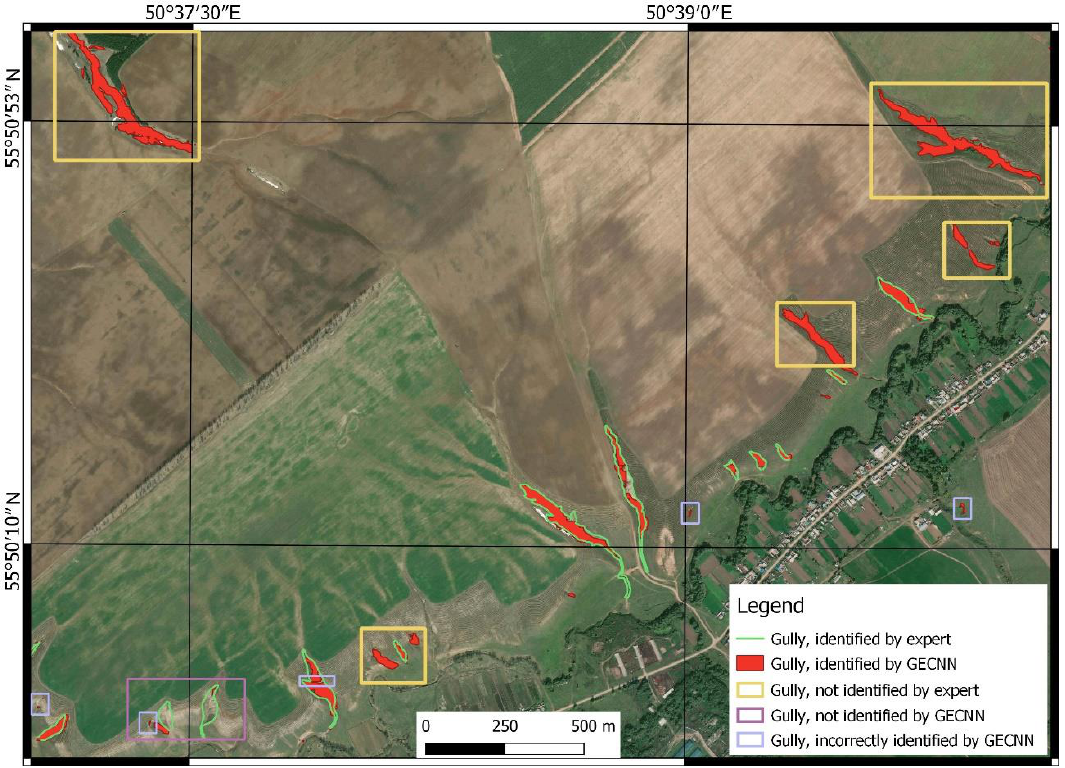
Figure 7. Typical errors detected when comparing gullies identified in different ways.